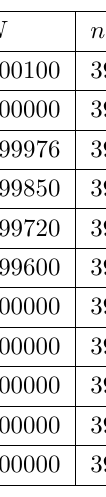
Table 2 . The table shows the our numerical results of E (0) solved with different parameters N and n T .